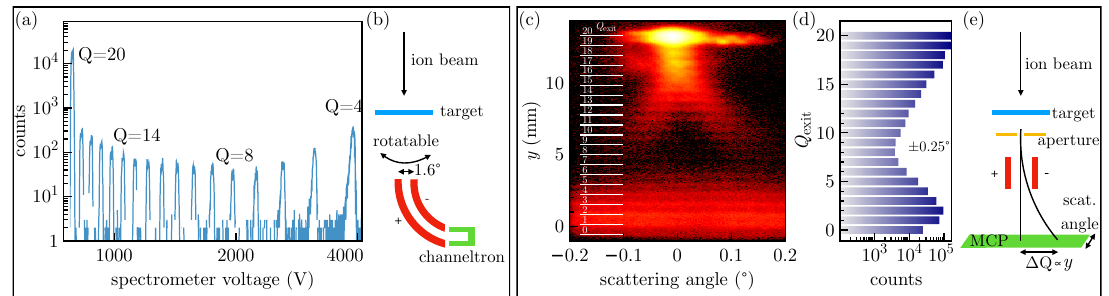
Figure 4. (Color online) ( a ) Charge state spectrum of 90 keV Xe 20 + ions transmitted through a 1 nm thick freestanding carbon nanomembrane. ( b ) Experimental scheme for ( a ) with an electrostatic analyzer as a detector with 1.6 ◦ acceptance angle. ( c ) 2D charge state spectrum of 180 keV Xe 20 + after transmission through a 1 nm thick carbon nanomembrane with different exit charge state positions marked by white lines and the scattering angle on the abscissa (please note the log-scale). The vertical position ( y ) can be converted into a charge state according to the deflection by an electric field indicated in ( e ). ( d ) Integrated charge state spectrum of ( c ) for scattering angles between − 0.25 ◦ and +0.25 ◦ . ( e ) Experimental scheme for ( c ) with a position sensitive MCP as a detector with 0.01 ◦ angular